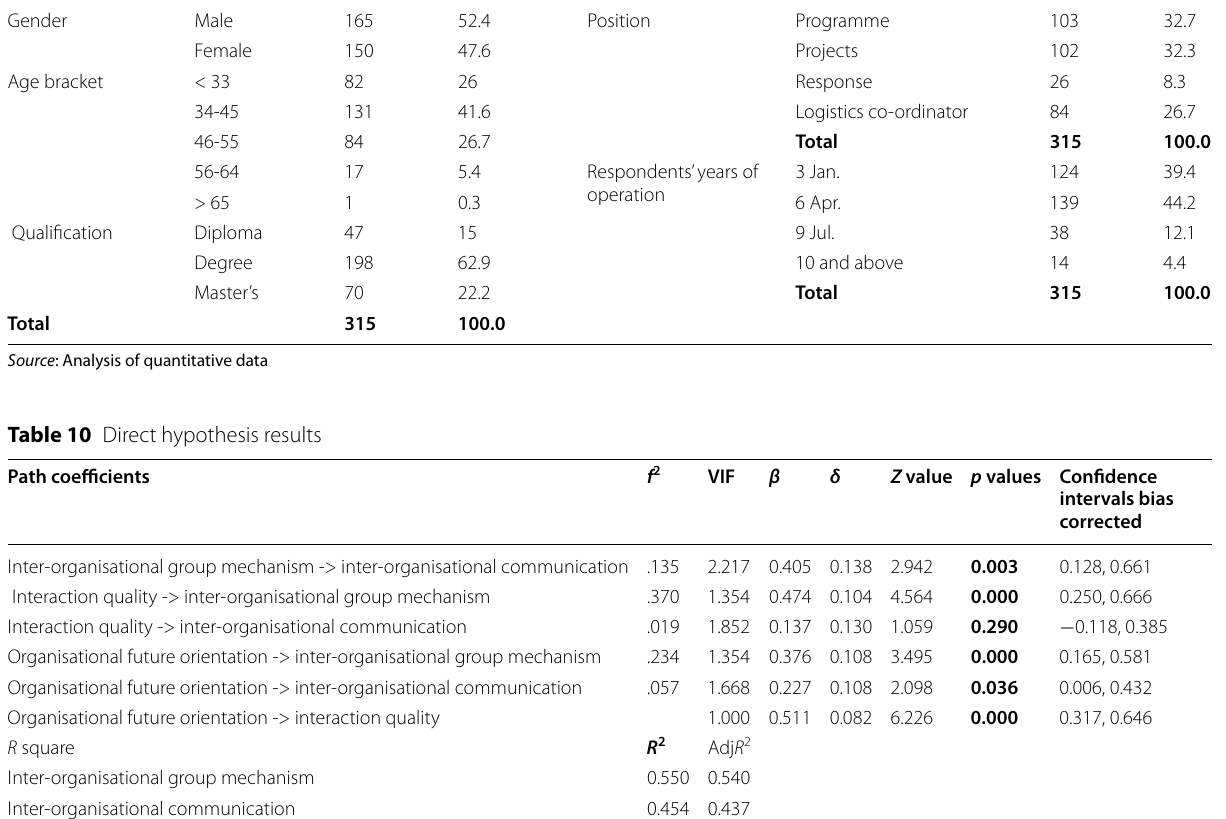
Table 9 The individual respondent characteristics Characteristics